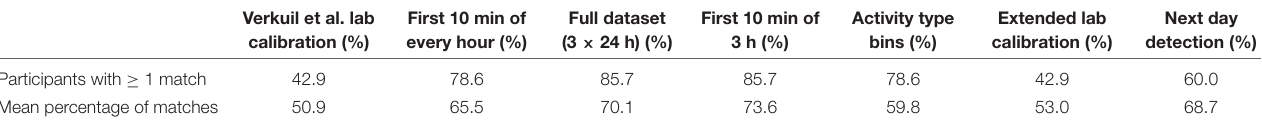
TABLE 3 | Matches between method-identified episodes of reduced additional HRV and self-reported episodes of stress and worry (expressed as percentages). Verkuil et al. lab calibration